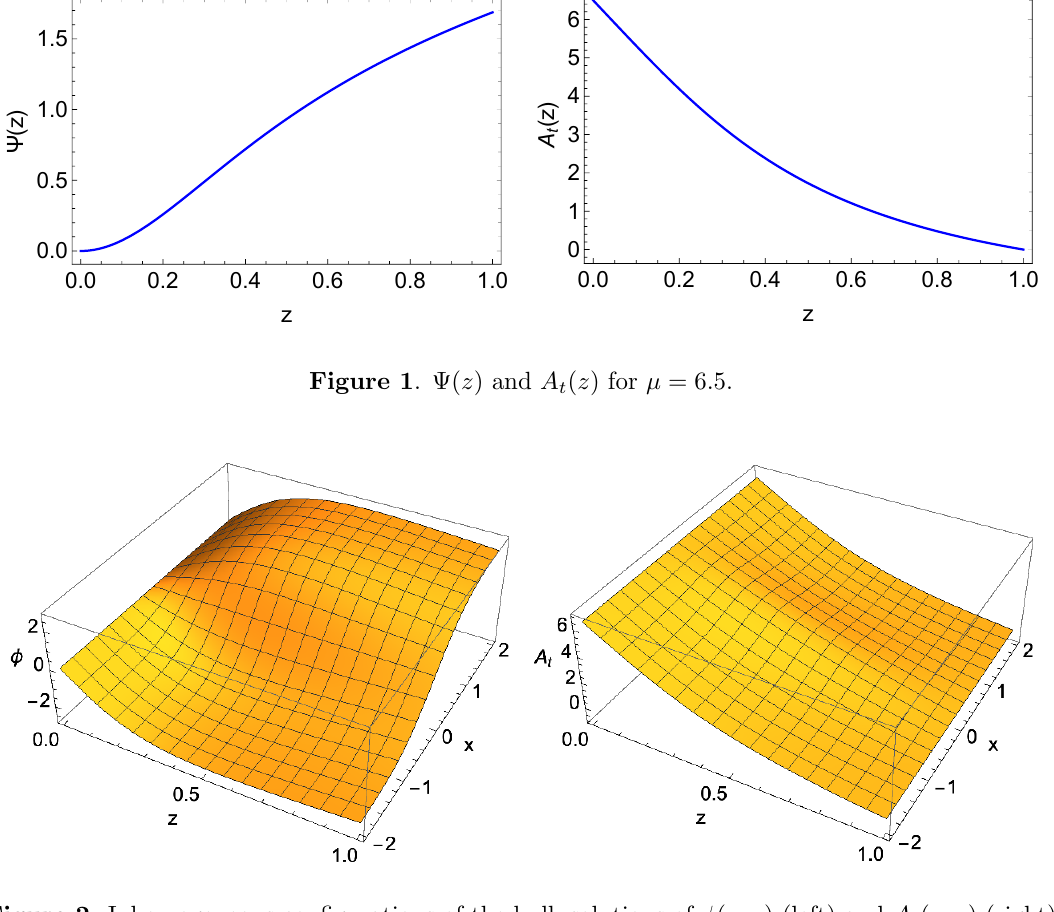
Figure 2 . Inhomogeneous con(cid:12)gurations of the bulk solutions of (cid:30) ( z; x ) (left) and A t ( z; x ) (right) with single node on the x -axis for (cid:22) = 6 : 5.